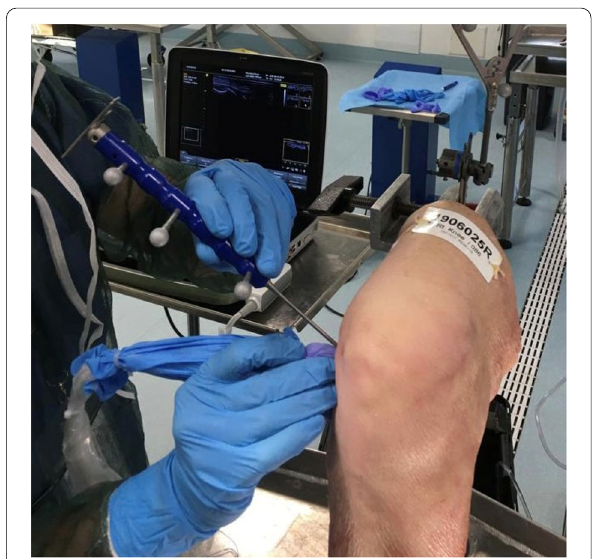
Fig. 2 Anatomic ALL insertions assessed by